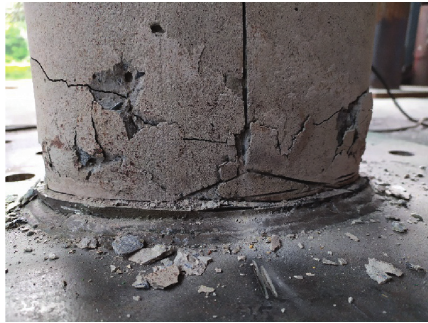
Figure 8: Typical damage mode of the